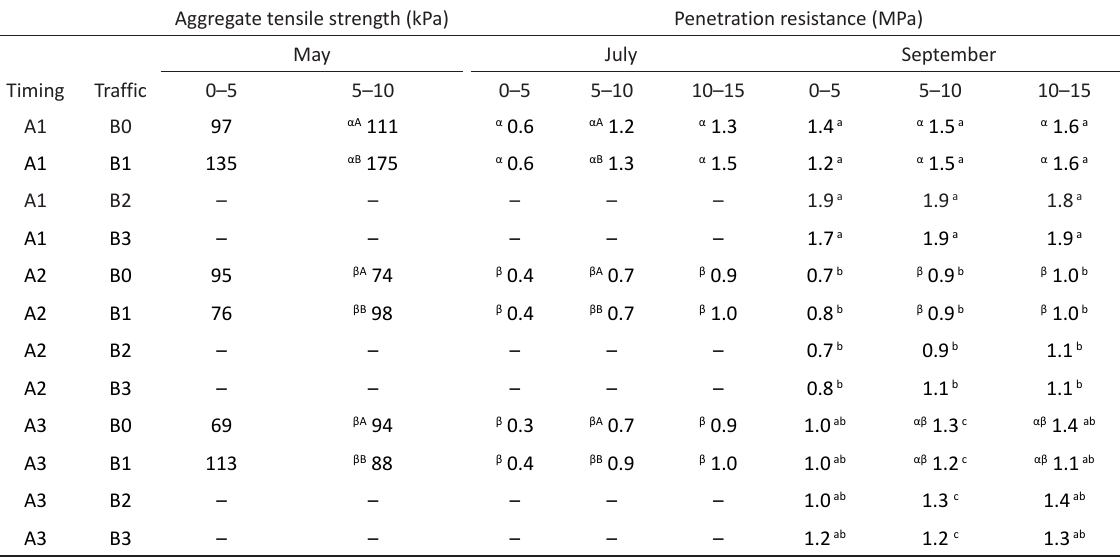
Table 4. Lsmean values of geometric mean tensile strength (kPa) of air-dried 8–16 mm aggregates in May and penetration resistance (MPa) measured at different depths (0–5 cm, 5–10 cm, 10–15 cm) in July (27.5 vol% water) and September 2016 (29.1 vol% water), affected by timing (Sowing date: A1 = early, A2 = medium, A3 = late) and traffic intensity (B0 = zero, B1 = one, B2 = two, B3 = three